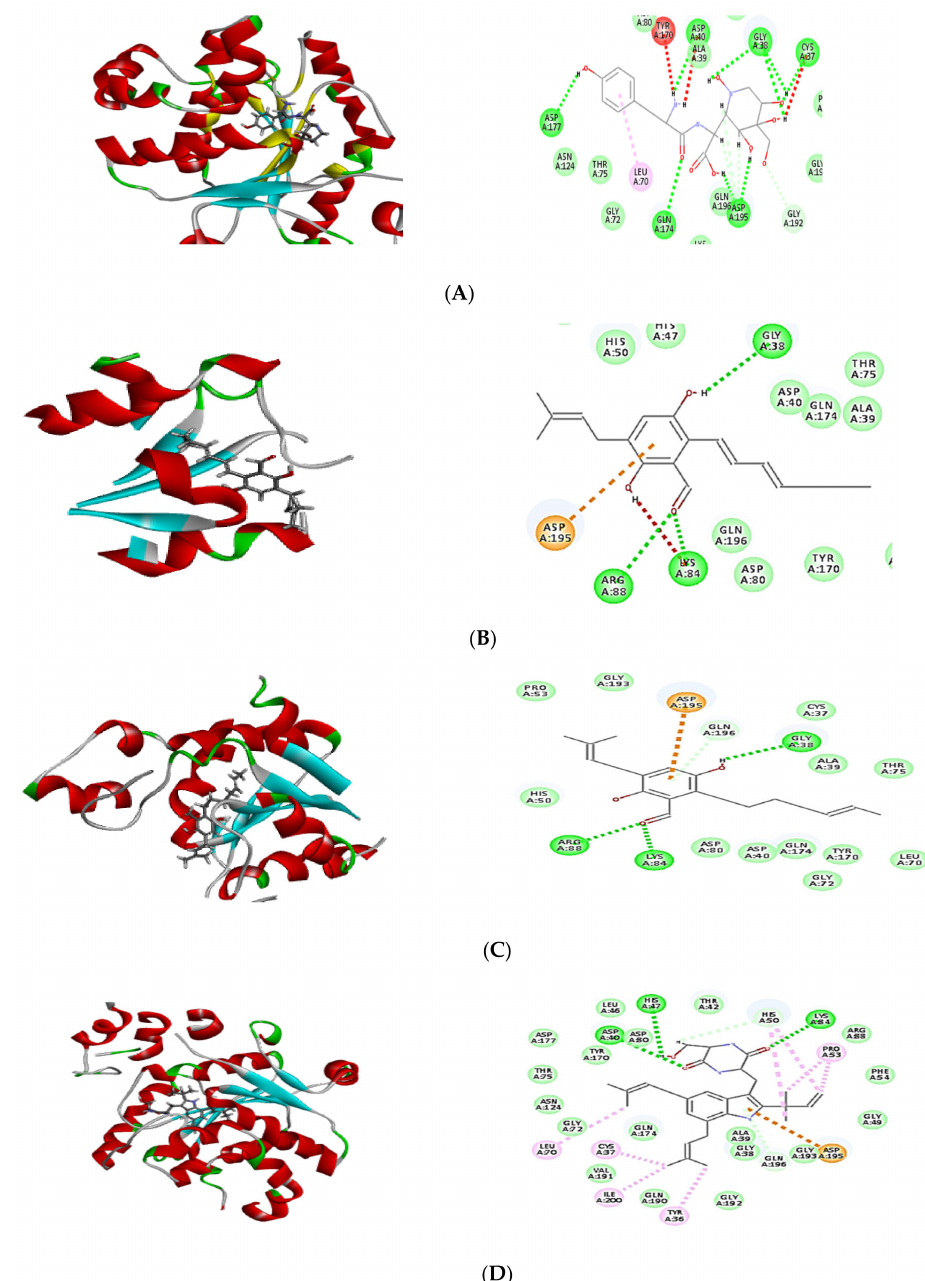
Figure 4. Two-dimensional (2D) and three-dimensional (3D) binding mode of the co-crystalized ligand (629) ( A ), dihydroauroglaucin ( B ); isotetrahydroauroglaucin ( C ); cristatumin B ( D ) with tyrosyl-tRNA synthetase. Residues are labeled with their three-letter amino acid code and their location. Hydrogen-bonding interactions are depicted with a green dashed line between the receptor and the ligand, whereas π –alkyl interactions are represented by a purple dashed